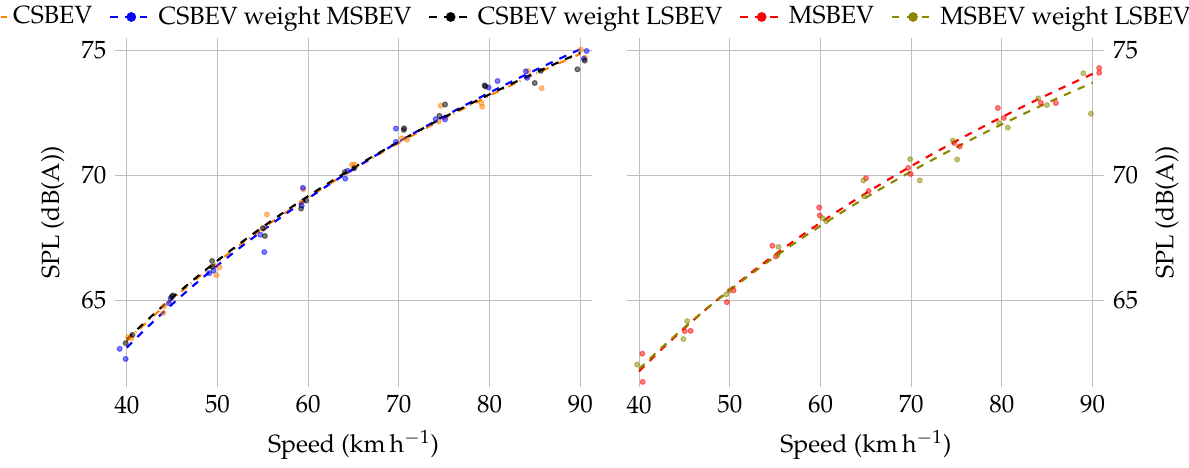
Figure 13. Air temperature corrected rolling SPL regression curves compared on CSBEV and MSBEV with different added weight on the left microphone.